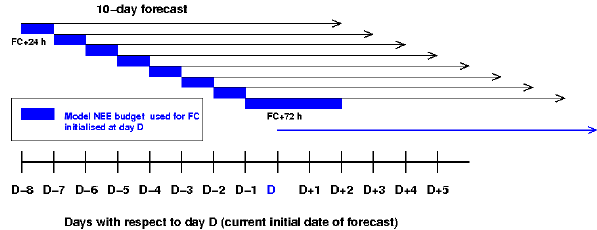
Figure 2. Schematic to illustrate how the 10-day NEE budget from the model is computed in BFAS for the forecast at day D by retriev- ing the past forecasts of accumulated NEE. Note that the retrieved NEE (computed by adding GPP and R eco ) has not been corrected by BFAS. The computation uses a set of 7 previous 1-day forecasts (initialized at D − 8, D − 7, D − 6, ... until D − 2) together with the latest 3-day forecast from the previous day (i.e. D − 1) as shown by the blue